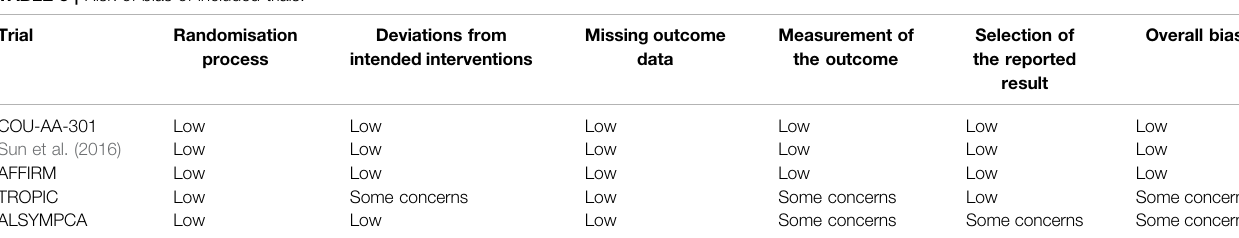
TABLE 3 | Risk of bias of included